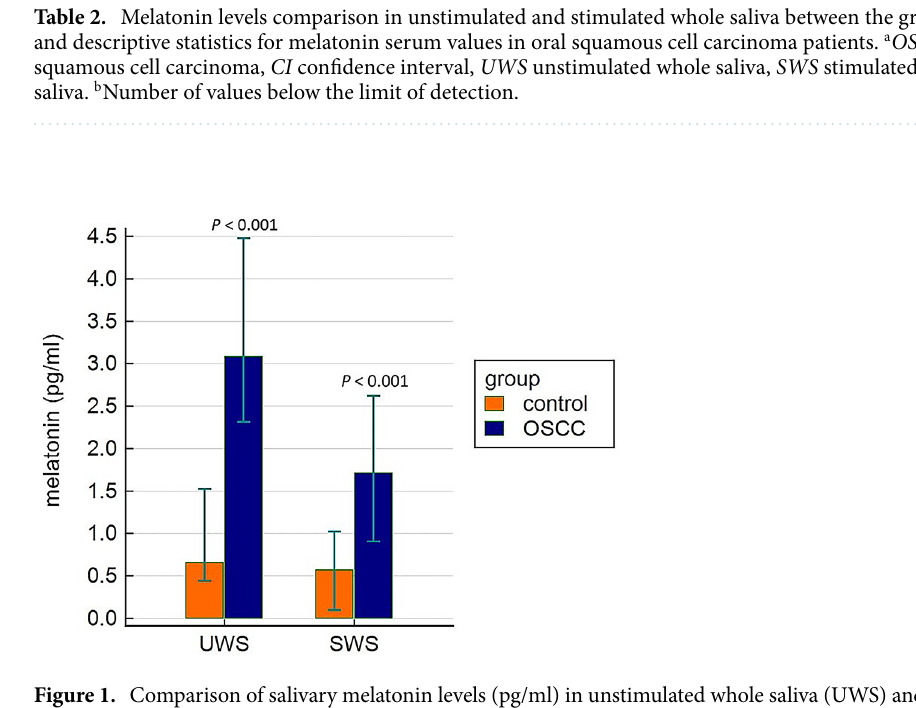
Figure 1. Comparison of salivary melatonin levels (pg/ml) in unstimulated whole saliva (UWS) and stimulated whole saliva (SWS) between the oral squamous cell carcinoma (OSCC) and the control group expressed with median and 95% confidence interval for the median.